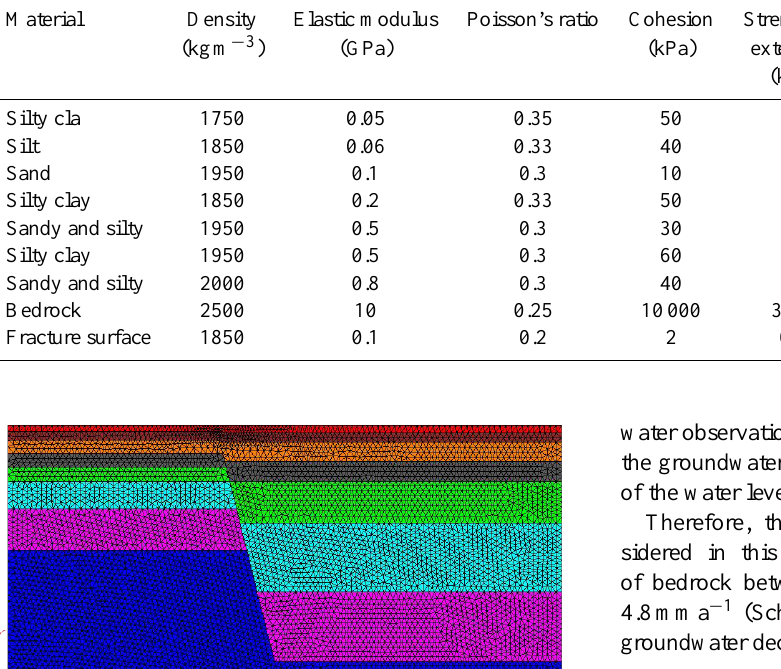
Table 2. The physical and mechanical parameters of each stratum in the model.